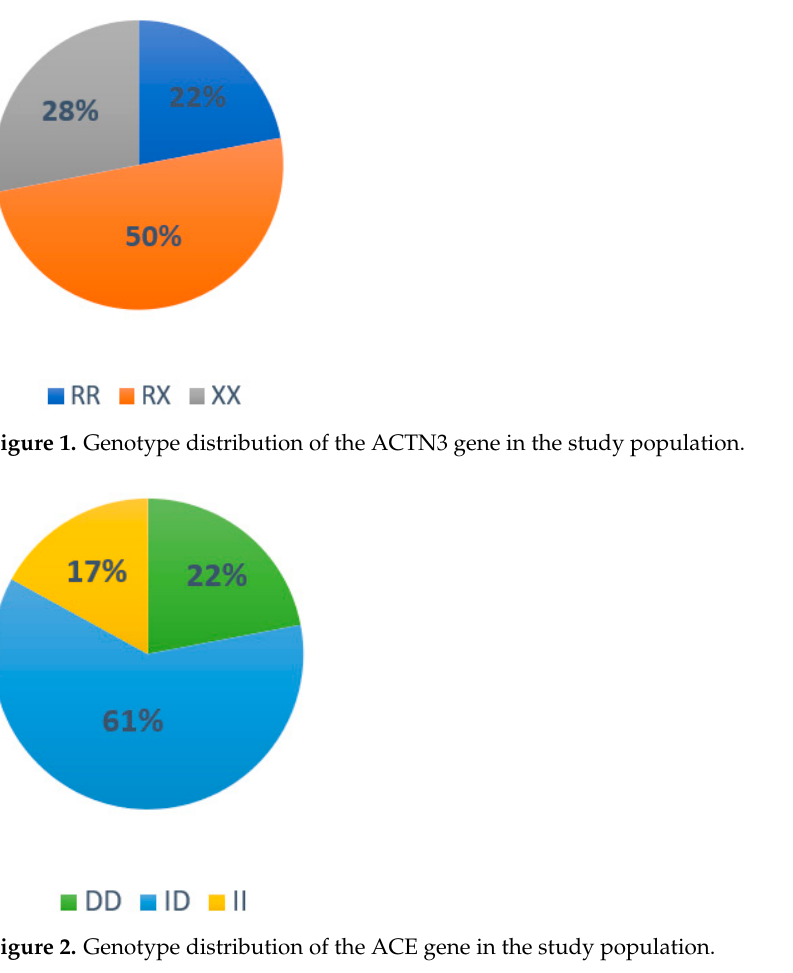
Table 2. Physical capacities before and after training.